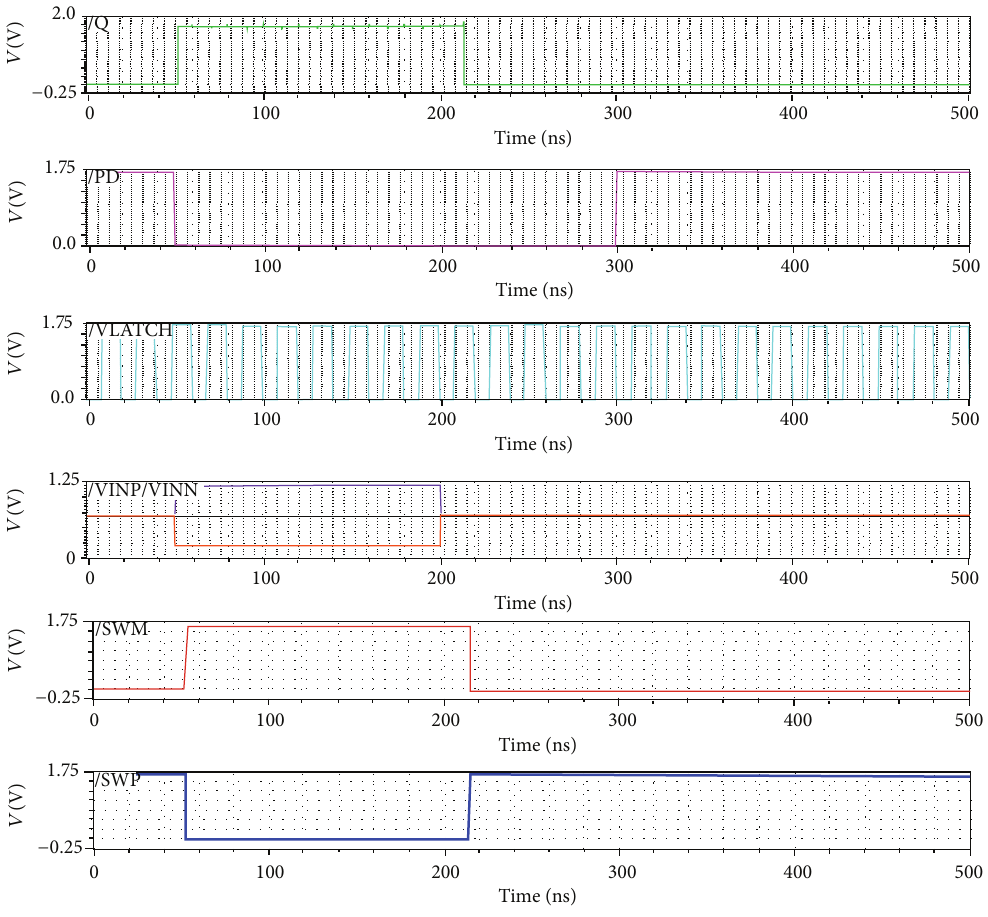
Figure 4: Corner analysis of the comparator input signals, VLATCH signal, and output signals (SWP and